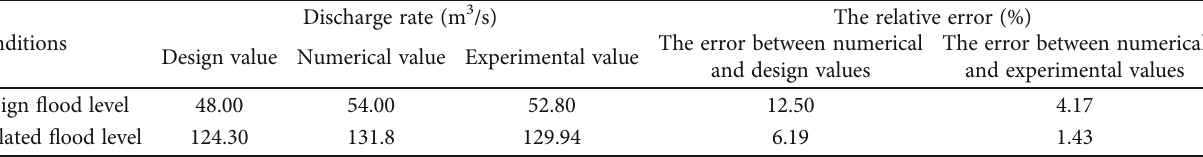
Figure 4: 3D model and boundary conditions. Table 2: The discharge capacity under di ff erent